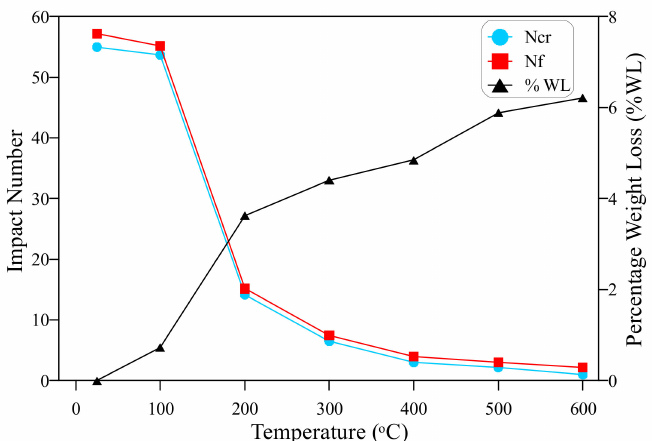
Figure 12. The relation of the impact number and percentage weight loss of the prism specimens at different